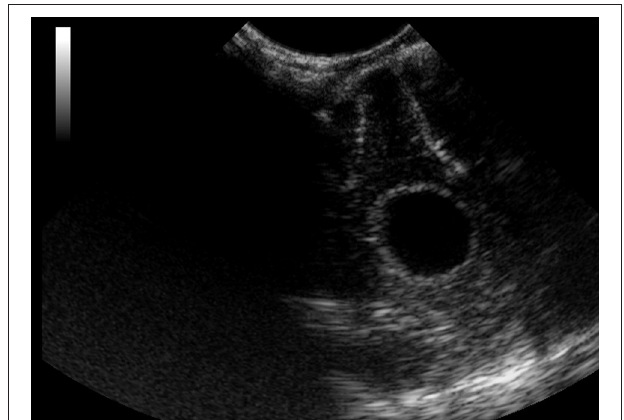
FIGURE 12 | Case 6. Intraoperative ultrasound view of a suspected abscess that was later diagnosed as isolated angiitis by histopathology following a post-mortem examination. The mass was located in the frontal lobe and appeared hypoechoic on ultrasound